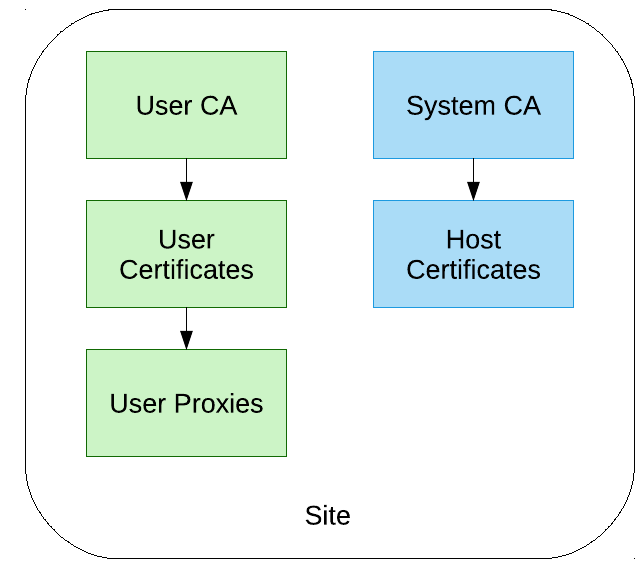
Figure 3. Set-up of the two certification authorities at each